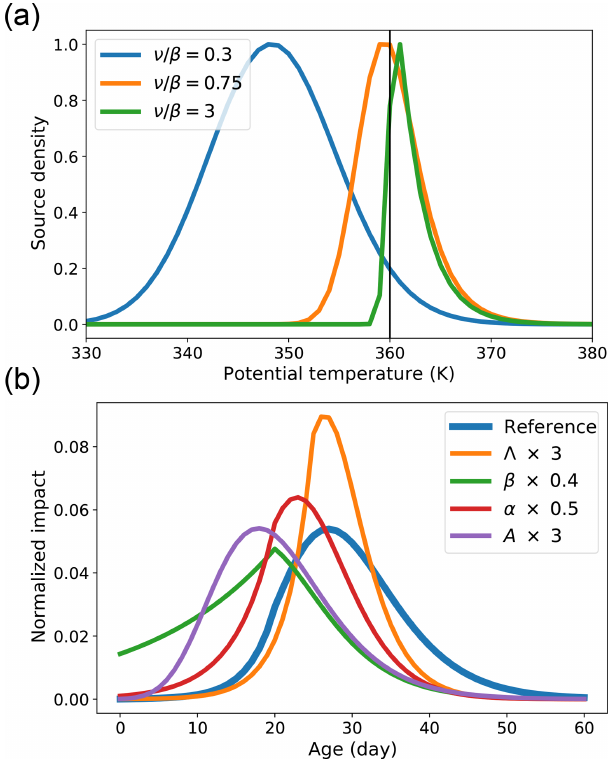
Figure 13. (a) Distribution of convective sources NP(θ) accord- ing to Eq. (3) for θ 0 = 360K, β = 0 . 4K − 1 and three values of ν/β : 0.3, 0.75 and 3 as indicated in the legend. The proportion of sources above the LZRH θ 0 in the three cases is, respectively, 4.7%, 55.8% and 97.4%. (b) Solution of Eq. (1) described by Eqs. (S5–S7) of the Supplement for the parameters given in the text and modified solu- tions according to the changes indicated in the legend. Each curve is normalized with respect to its integral in the displayed interval.